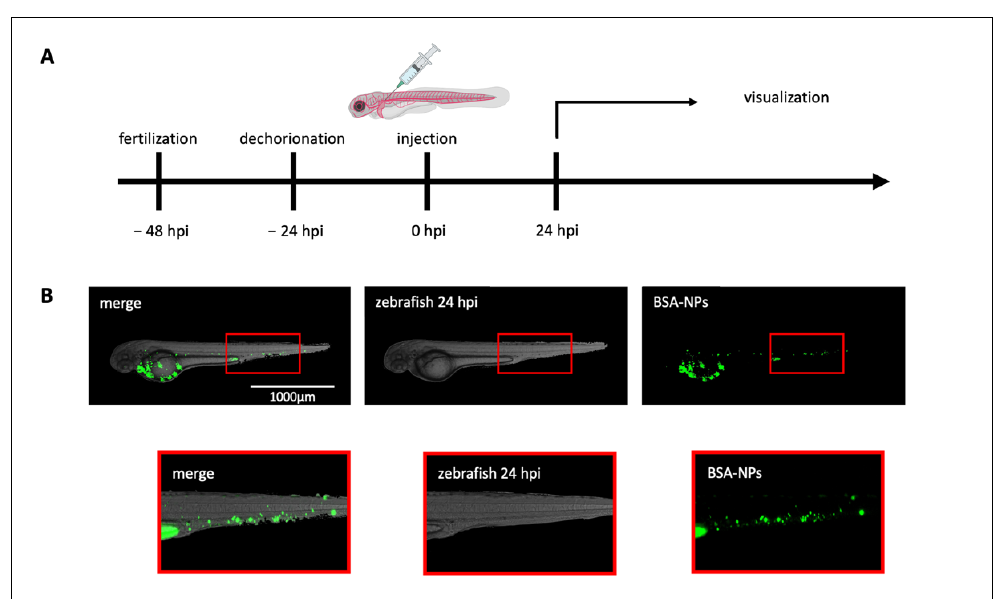
Figure 2. Zebrafish as an animal model for biodistribution studies: ( A ) Timeline of the experimental procedure. ZF were followed for a total of 5 days. The reference point was set at the moment of the injection (0 h post-injection, hpi), which was performed 48 h post-fertilization. Embryos were manually dechorionated and incubated with PTU to prevent the formation of pigmented areas in the body 24 h prior to the injection ( − 24 hpi). ( B ) BSA-NPs were injected in the duct of Cuvier and analyzed 24 hpi demonstrating an accumulation of fluorescent BSA-NPs in the tail of ZF, known as posterior blood island (PBI), which is a macrophage-rich area. Magnification 40×. Scale bar 1000 μ m.